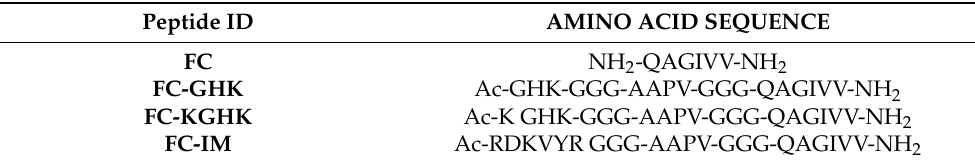
Figure 2. Scheme of the peptide scaffold construct. Table 1. Amino acid sequences of the designed peptides.